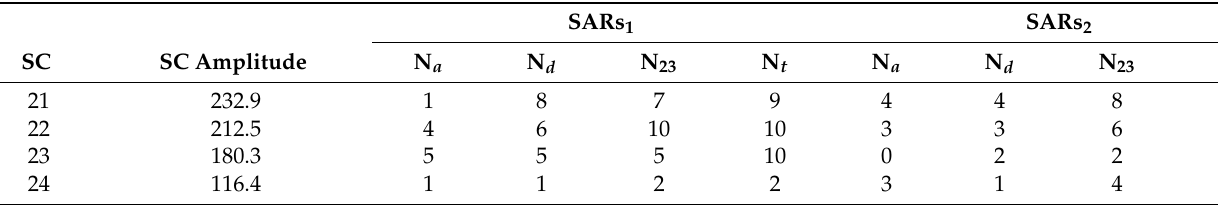
Table 1. Solar cycle distribution of SARs from 1976 to 2017.